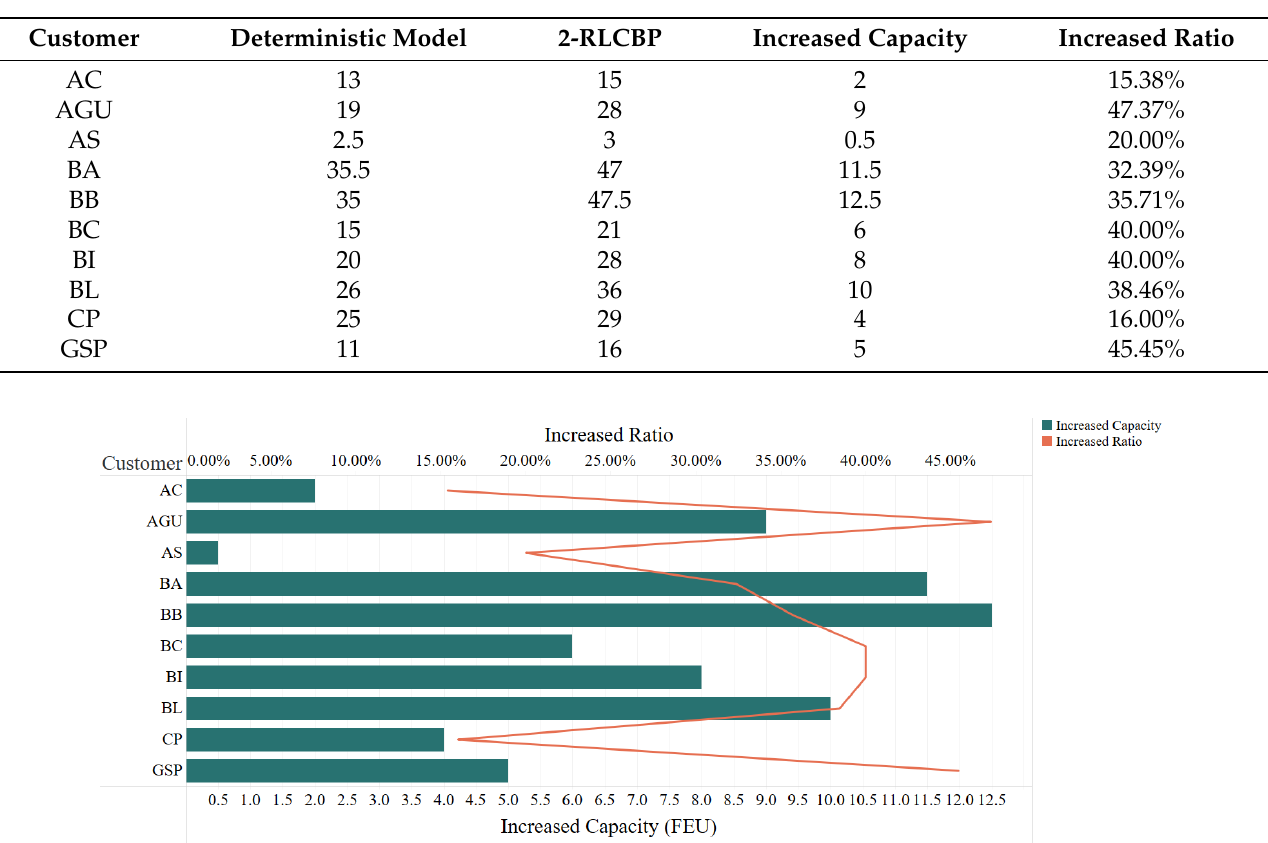
Figure 5. Result of 2-RLCBP. Table 7. Results comparison of 2-RLCBP and deterministic model.